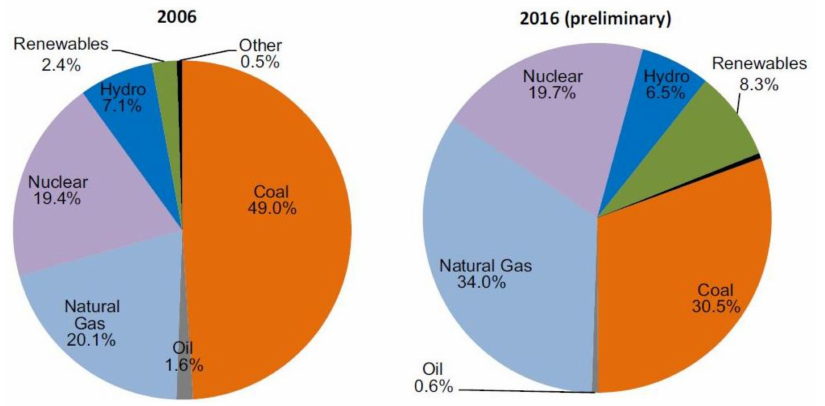
Figure 2. An indication of the increase in renewable energy sources, adapted from [45].